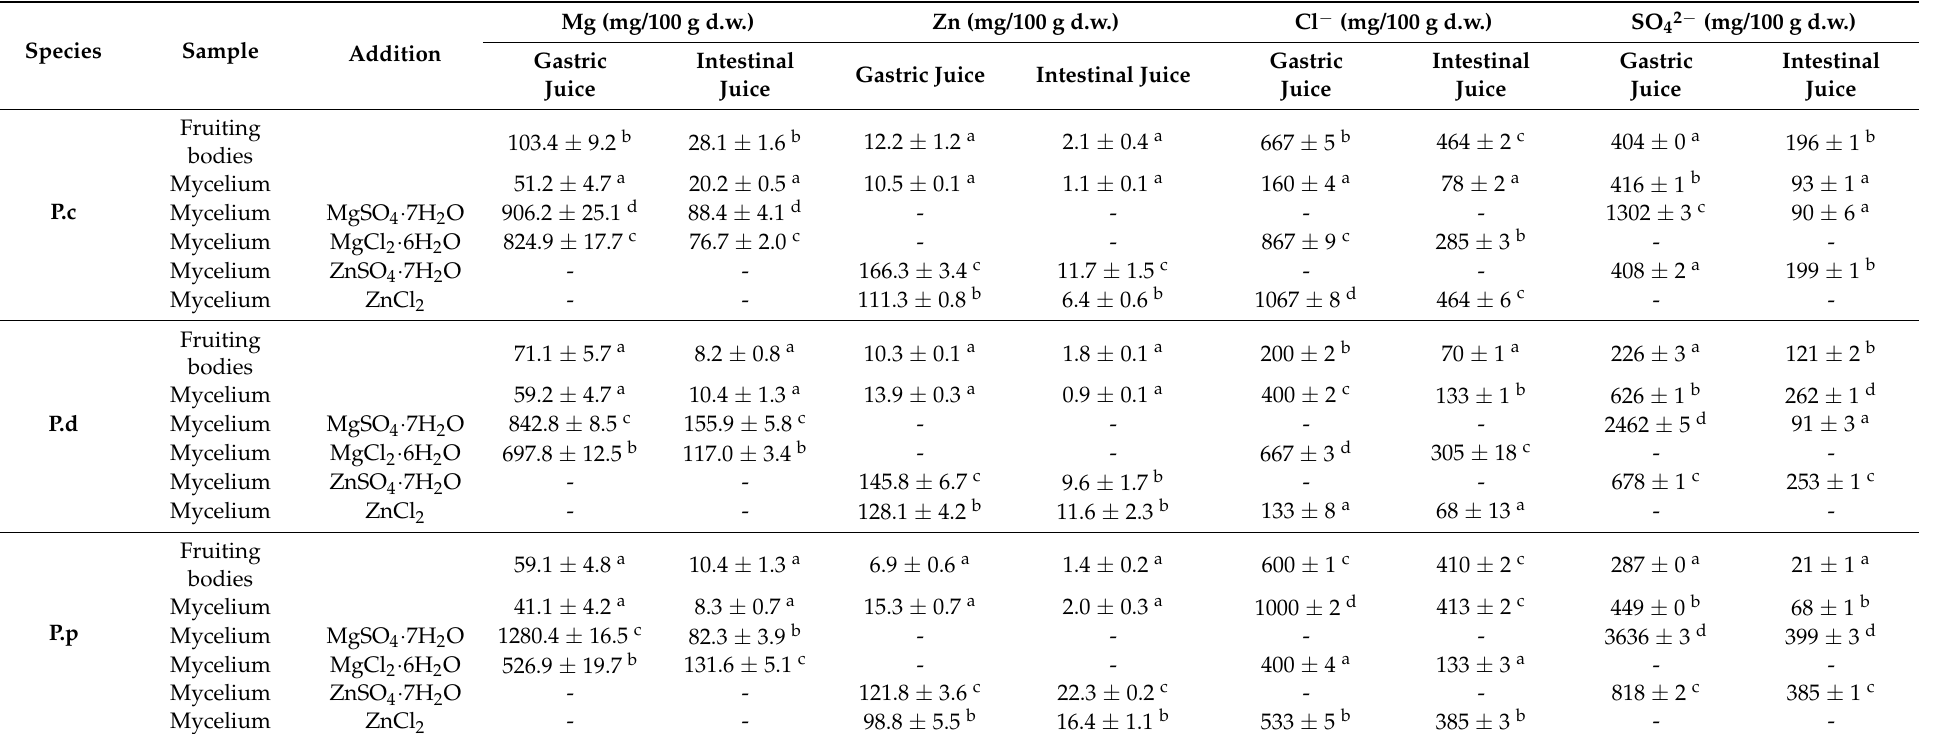
Table 2. The concentration of metals (Mg and Zn) and anions (Cl − and SO 42 − ) extracted into the artificial digestive juices from the biomass of P.c— Pleurotus citrinopileatus, P.d —Pleurotus djamor , and P.p —Pleurotus pulmonarius (mg/100 d.w.).